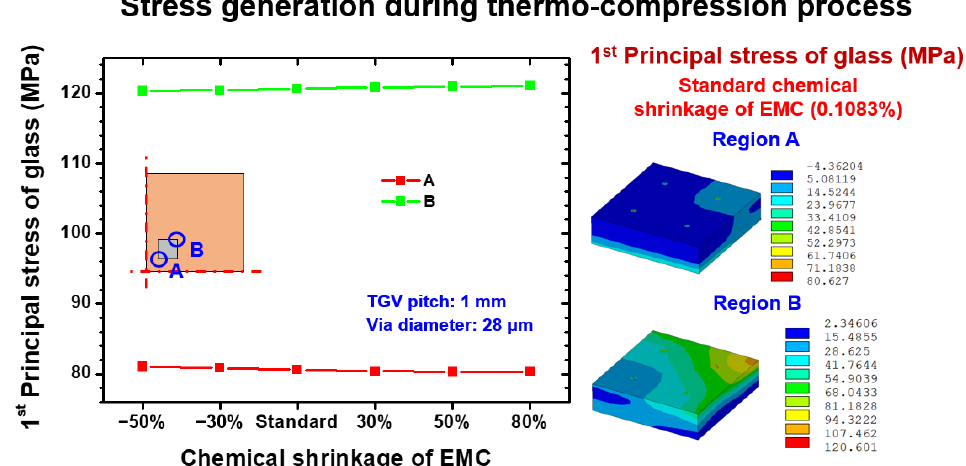
Figure 8. EMC shrinkage dependence first principal stress on the relevant location of the glass interposer during the thermocompression process.